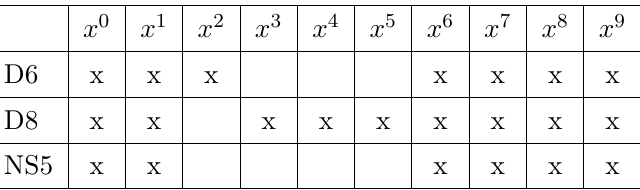
= γ P and P 81 π 2